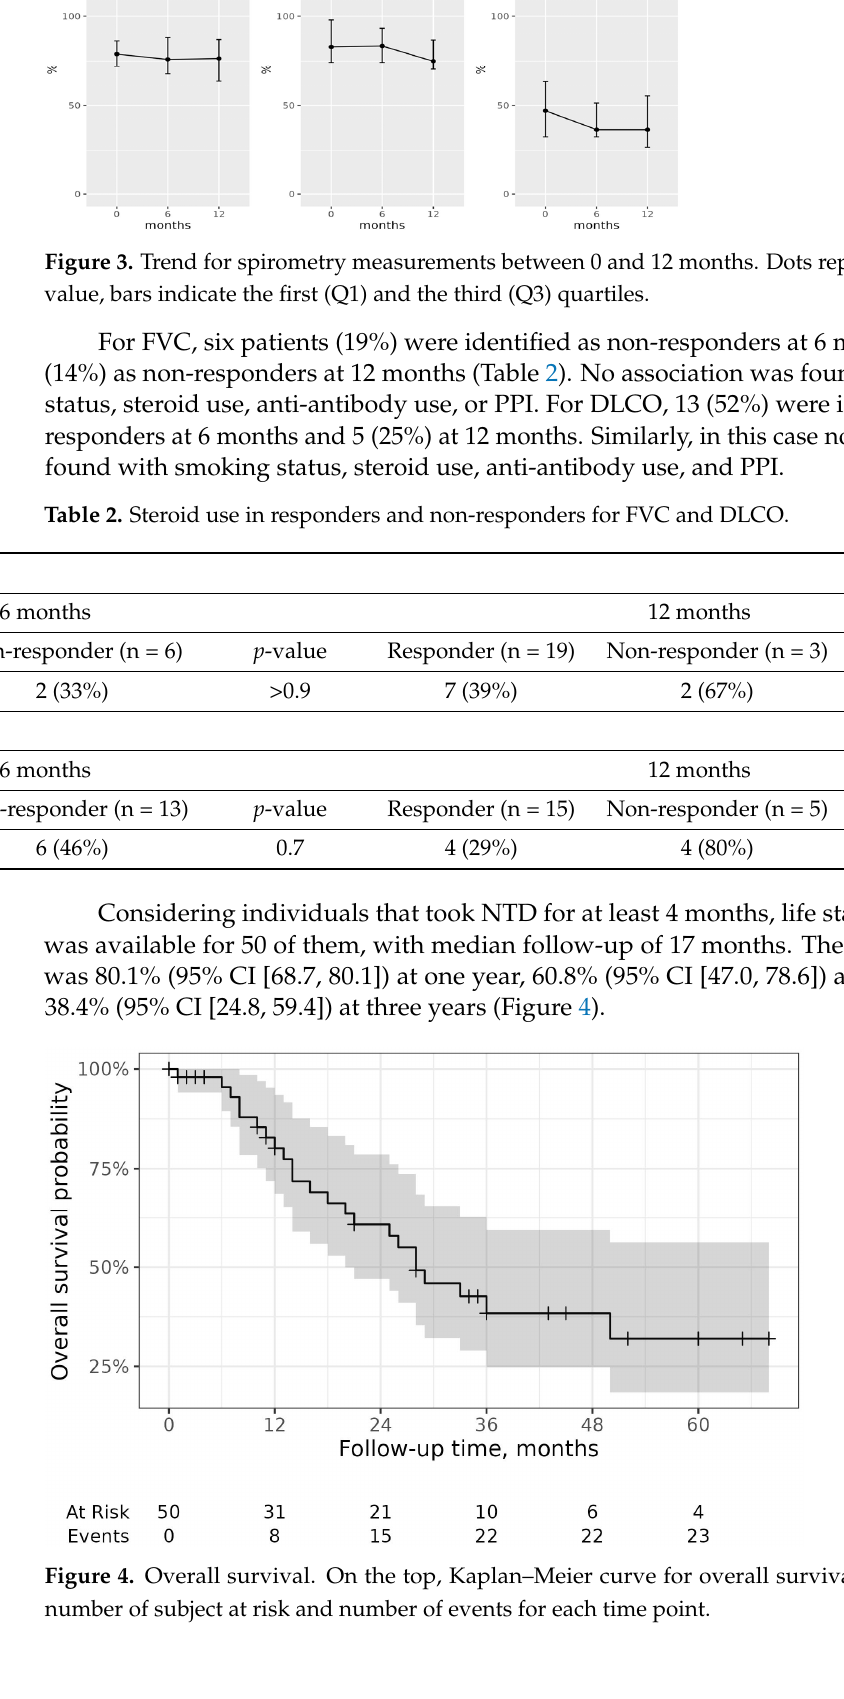
Figure 2. The 12 ‐ month trend for spirometry measurements. Box ‐ plots representing levels of FVC, FEV1 and DLCO at baseline and after 12 months.